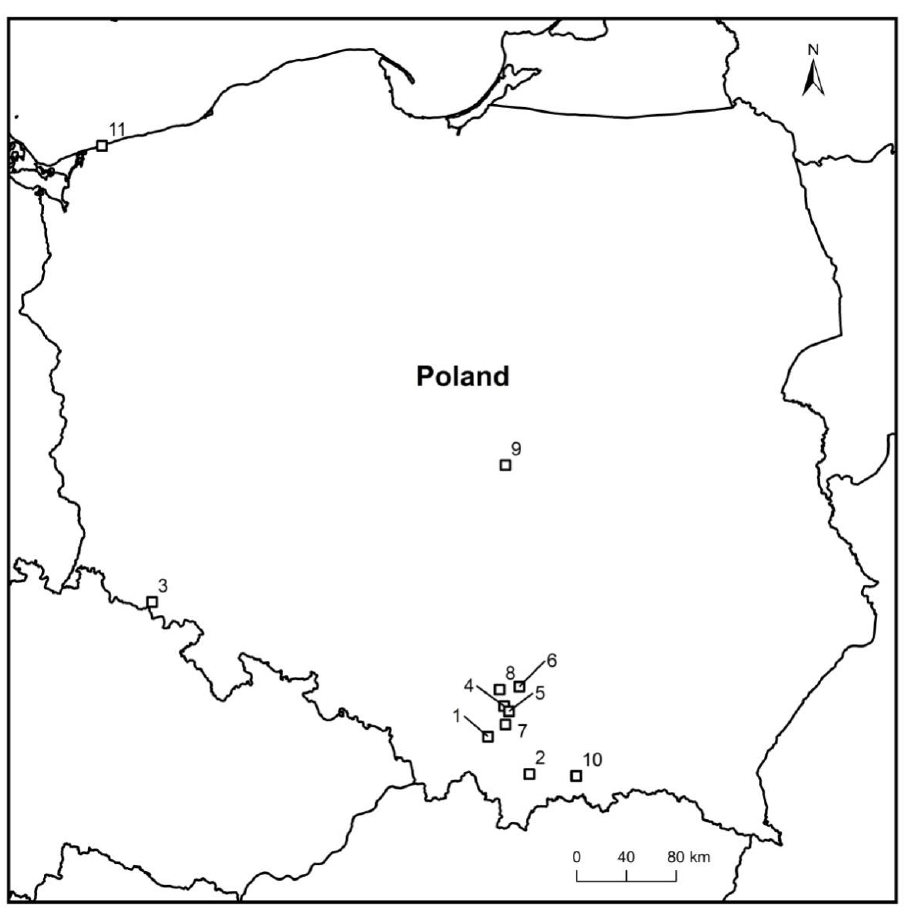
Figure 1. Locations of sampling sites in Poland: 1–Brody, 2–Gorce Konina, 3–Kowary, 4–Kraków Młynówka, 5–Kraków Zakrzówek, 6–Miechów Domiarki, 7–Myślenice, 8–Ojców, 9–Rogów, 10—Stary S ˛acz, and